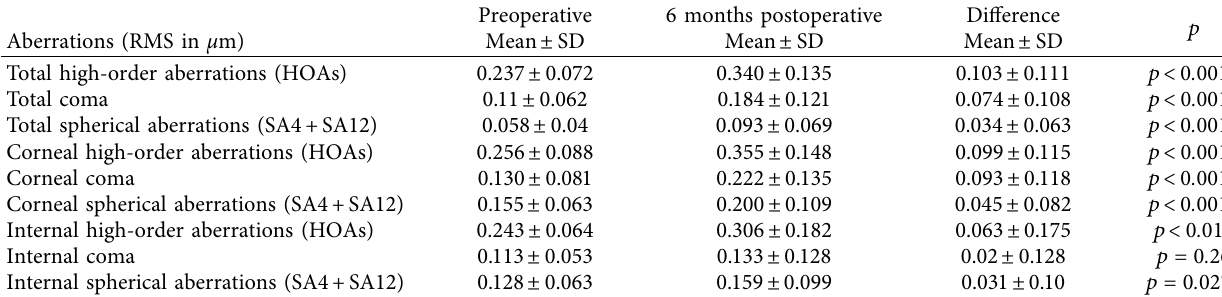
Table 3: Evolution of RMS ocular total, corneal, and internal aberrations ( µ